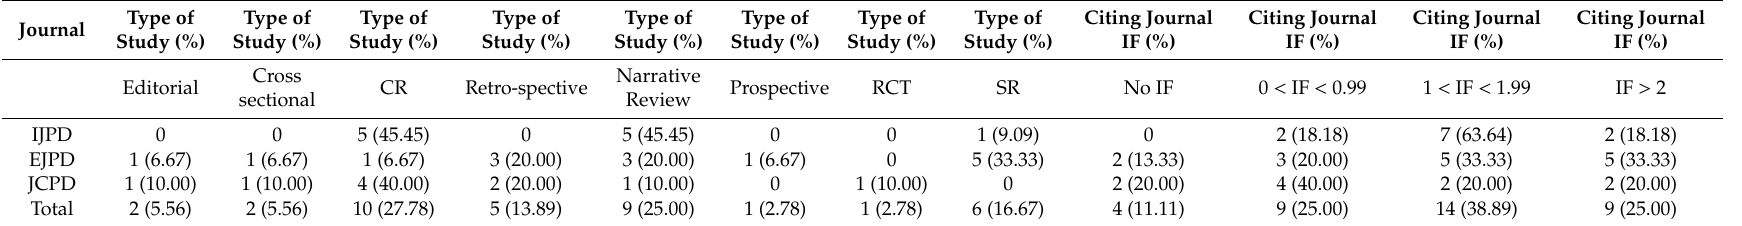
Table 6. Characteristics of the articles citing the highly cited CRs published in major PD